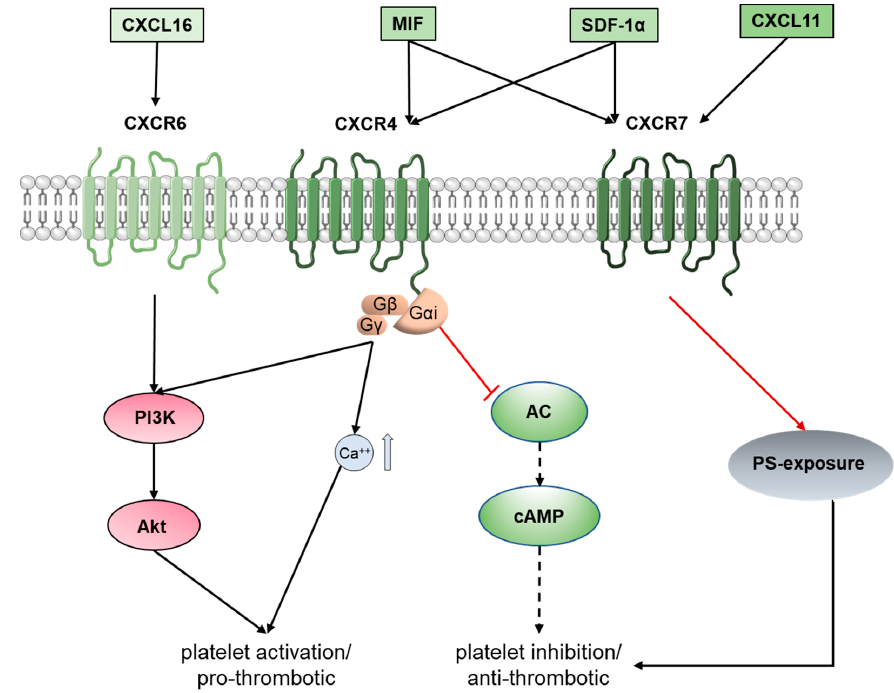
Figure 2. Regulation of platelet activation by CXCR chemokine receptors. Different chemokine receptors like CXCR6, CXCR4 and CXCR7 induce GPCR signaling in platelets. The chemokines CXCL16, and CXCL12 / SDF-1 α activate the phosphatidylinositol 3-kinases (PI3K) pathway leading to the activation of protein kinase B (Akt) and calcium mobilization resulting in platelet activation.